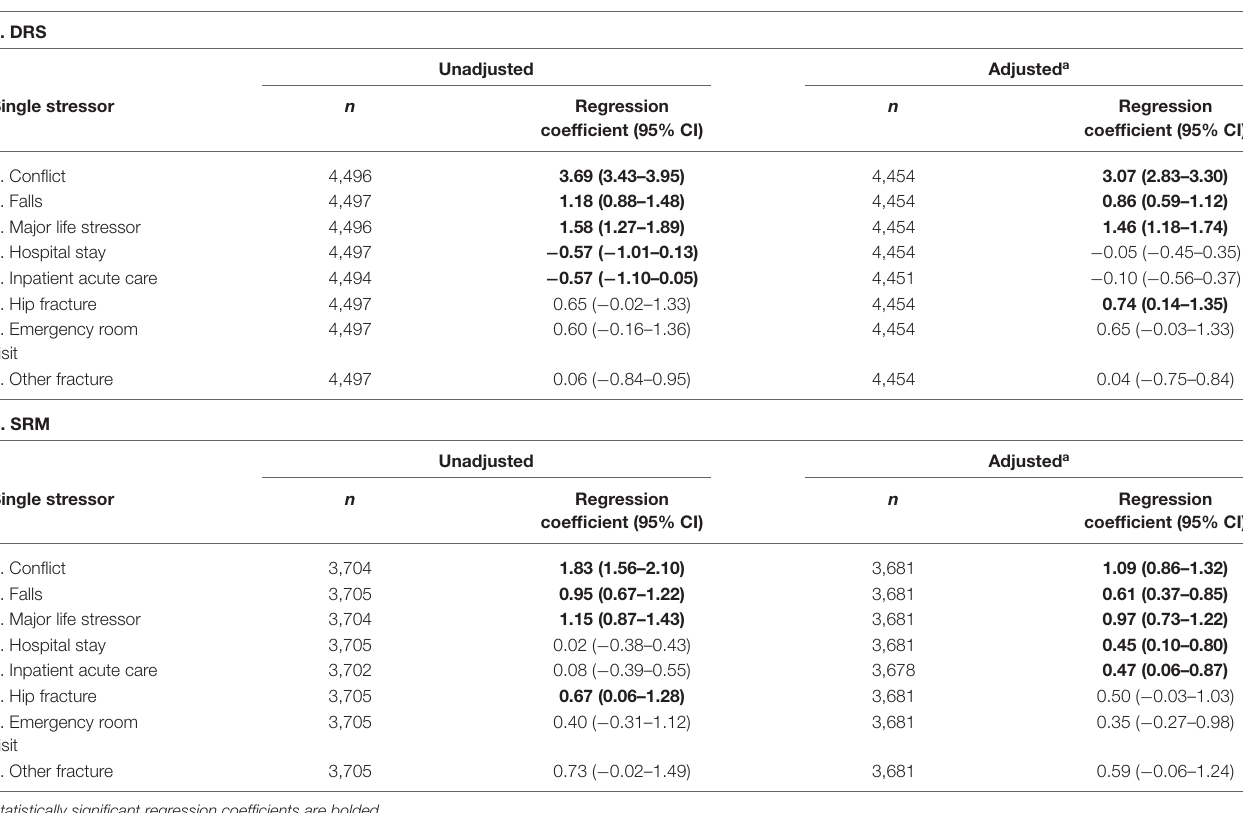
TABLE 3 | Overview of the association between single stressors and: a. observer-reported mood (DRS); b. self-reported mood (SRM) in the subpopulation with SRM complete. a.